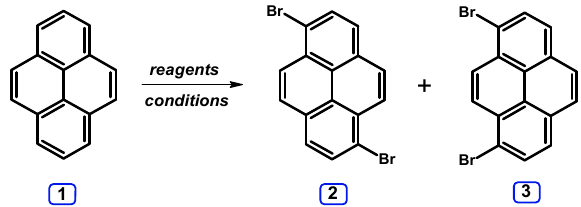
Table 1. The reported bromination reactions of pyrene.